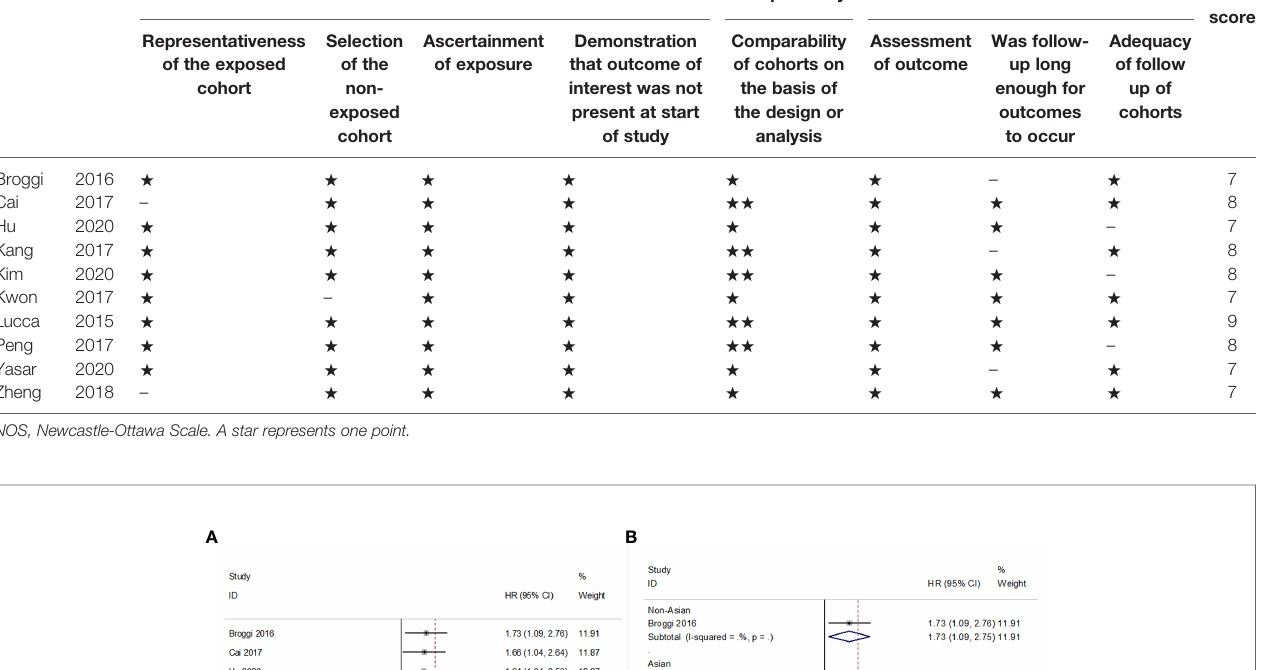
TABLE 2 | Quality assessment conducted according to the NOS for all included studies.